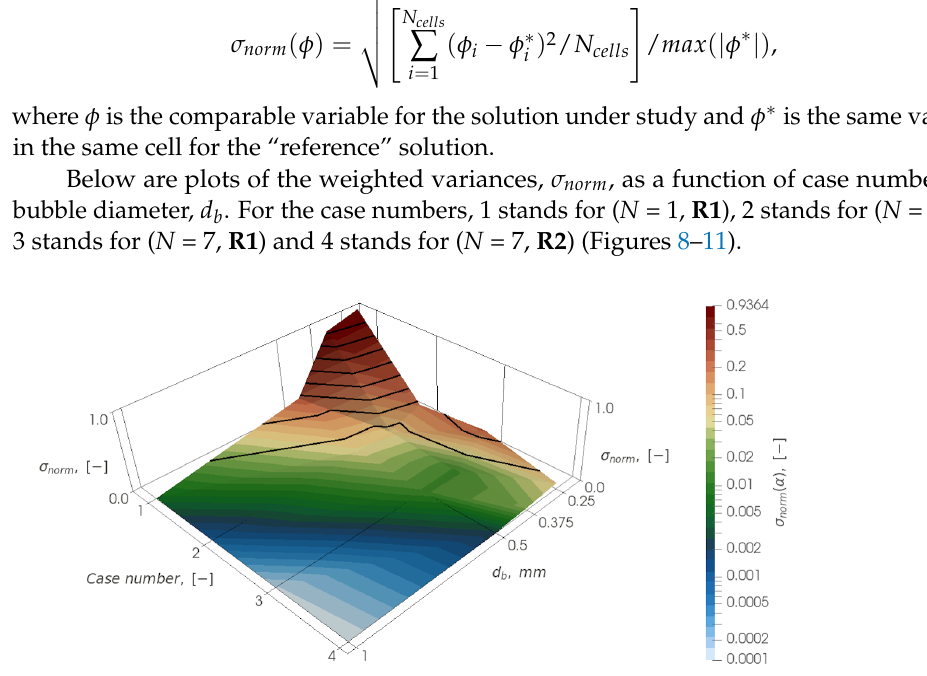
Figure 8. Distribution of a weighted variance σ norm for the bubble volume fraction, α b .